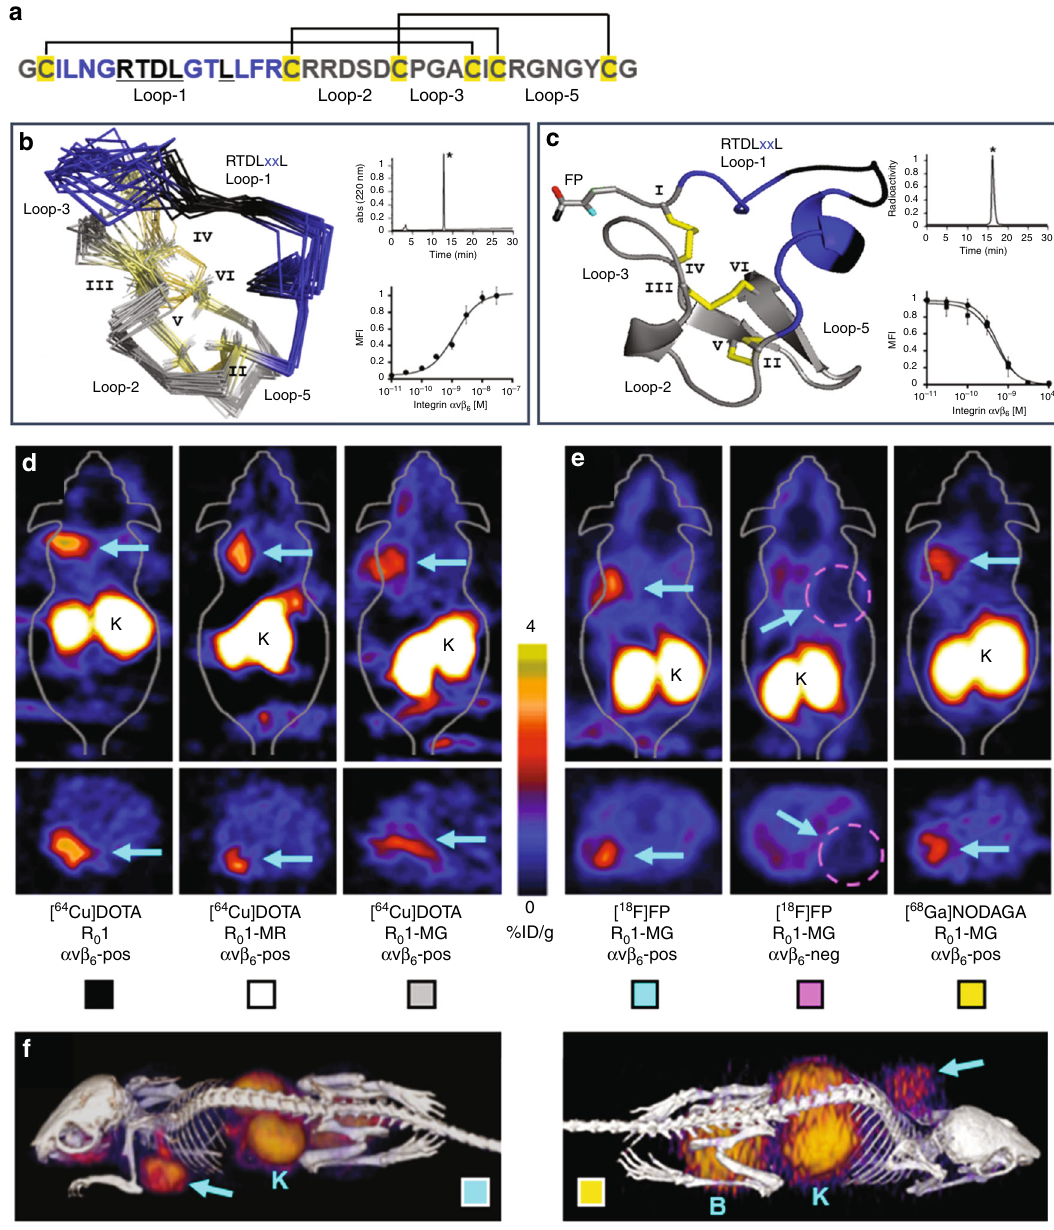
Fig. 1 Summary of the knottin PET ligand. a Primary structure of lead candidate R 0 1-MG. The engineered active loop-1 is shown in blue. The integrin a v β 6 core binding motif, RTDLxxL, is shown in black. The framework residues are shown in gray. Cysteine residues are shown in yellow and the pattern of disul fi de bonds are indicated by the connecting lines. b Ensemble of 10 lowest energy three-dimensional 1 H NMR of R 0 1-MG structures. c Crystal structure of non-radioactive reference standard, [ 19 F]FP-R 0 1-MG-F2, at <1 Å. The carbonyl oxygen of the ester is shown in cyan. The fl uorine atom is shown in red. The methyl carbon is shown in black. The insert on top shows the RP-HPLC trace of R 0 1-MG, and the radio-RP-HPLC trace of the puri fi ed clinical-grade PET tracer [ 18 F]FP-R 0 1-MG-F2, respectively. The product is indicated by the asterisk. The insert on the bottom shows b the equilibrium binding curve of between R 0 1-MG expressed on yeast surface and soluble human integrin α v β 6 ( K D = 1.24 ± 0.21 nM S.D.), and c the competition binding between unlabeled R 0 1-MG (IC 50 = 0.61 ± 0.31 nM S.D., circles) or the N-terminus labeled version [ 19 F]FP-R 0 1-MG-F2 (IC 50 = 0.56 ± 0.46 nM S.D., squares) vs. yeast surface expressed R 0 1-MG, respectively. d Comparison at 1 h post injection of the top 3 [ 64 Cu]DOTA-labeled PET tracer candidates, R 0 1 (black), R 0 1-MR (white) and R 0 1-MG (gray). e Comparison at 1 h post injection of the [ 18 F]FP labeled lead candidate R 0 1-MG in integrin α v β 6 positive (cyan) vs. α v β 6 negative tumor models (magenta, dashed circle in the fi gure). In vivo validation of the [ 68 Ga]NODAGA-R 0 1-MG at 1 h post injection (yellow). f Volume rendered PET/CT images of [ 18 F]FP-R 0 1-MG (cyan) and [ 68 Ga]NODAGA-R 0 1-MG (yellow) in integrin av β 6 positive models at 1 h post injection. d – f The cyan arrows point to the tumor. The letters K and B represent the kidneys and bladder, respectively. ( d – f and Table 3, below) Box colors are colored legends that cross-relate the images to the quanti fi cation